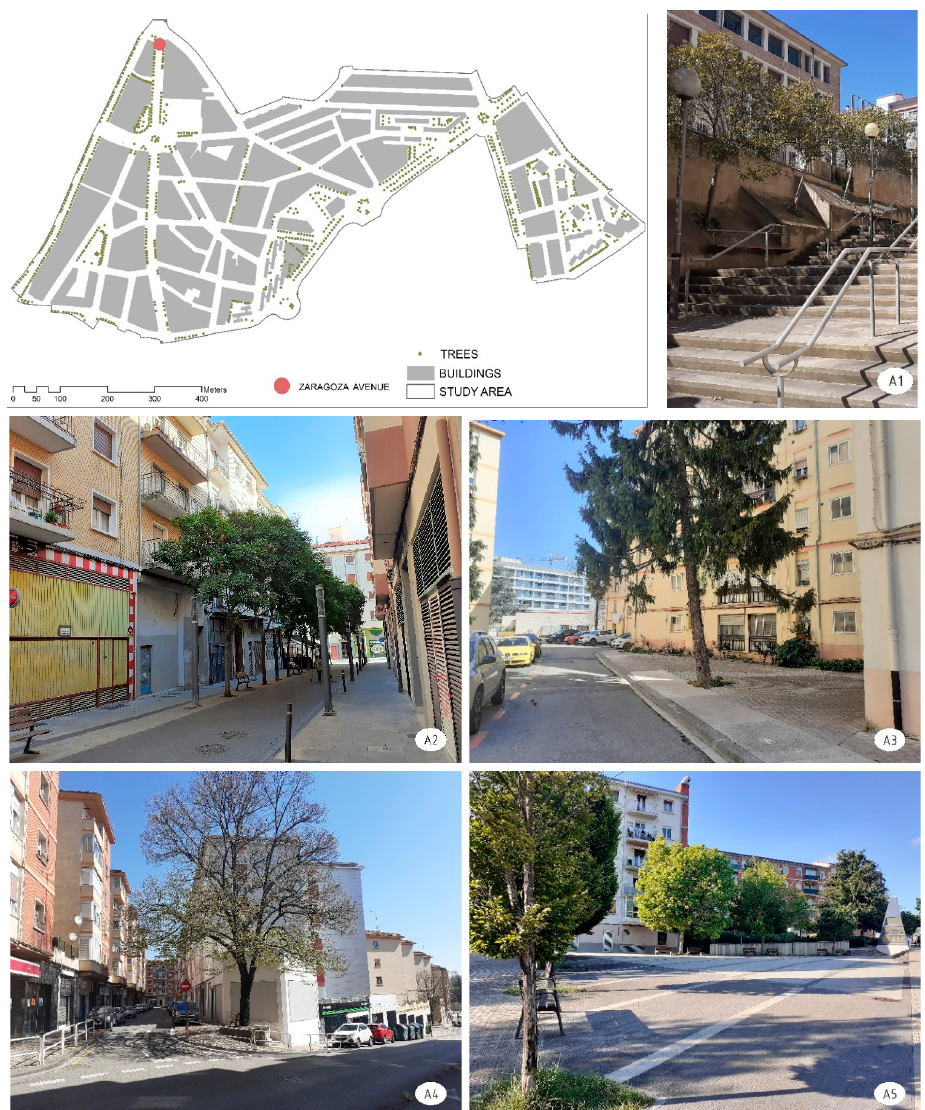
Figure 10. Existing green spaces: